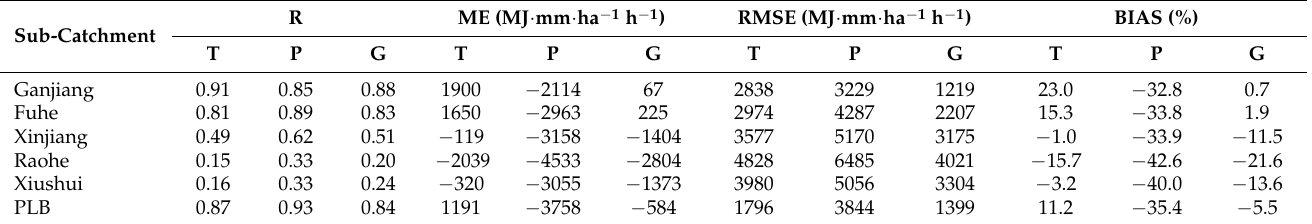
Table 3. Performance comparison of three SPPs for rainfall erosivity at different sub-catchments.